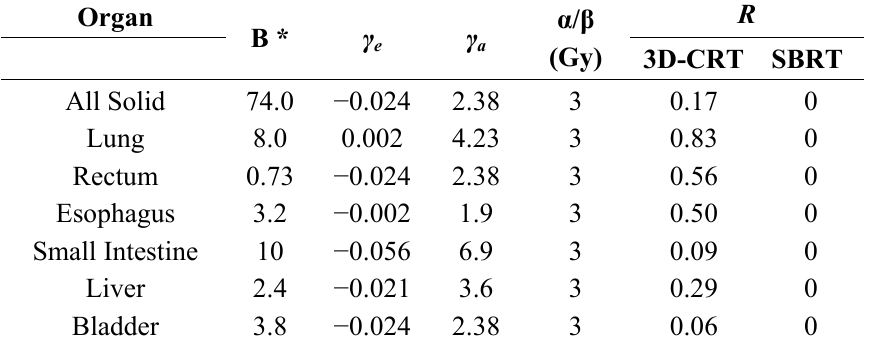
Table 1. Parameters used for EAR calculation according to Equations (4)–(7). For each organ, the parameters β (expressed as excess case per 10,000 PY/Gy), γ taken from [30]. For esophagus R = 0.5 was assumed since no specific R value is reported in